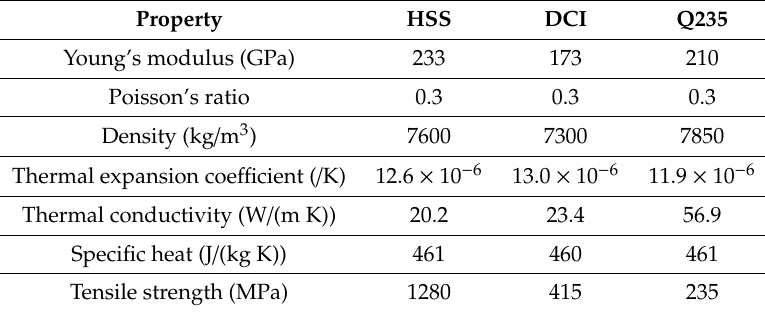
Table 2. Mechanical and thermal properties of the high-speed steel (HSS) work roll at room